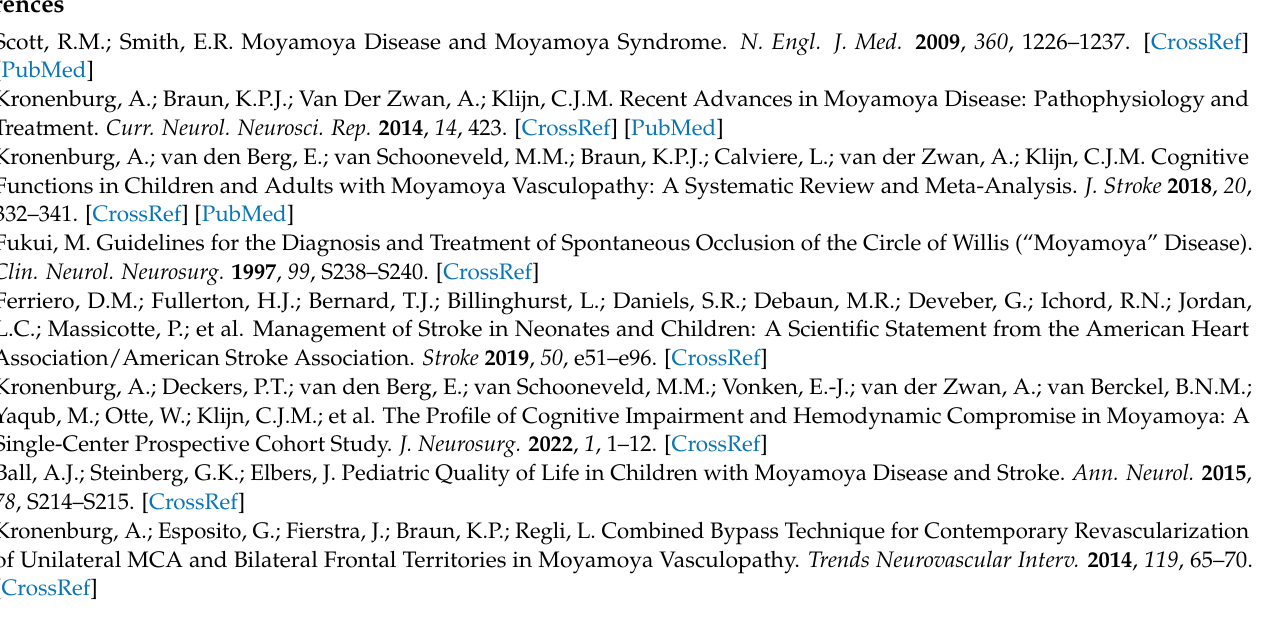
Figure A2. Z -scores at follow-up. ( A ) z -scores of neurocognitive tests on follow-up (conservative treatment) for the total group and for adults only for all seven cognitive domains. The numbers represent the amount of patients with a z -score below − 1.5 SD compared to the total number of patients with a valid domain score per group. Scores significantly different from the population mean (one sample t -test) are noted with * ( p < 0.05); ** ( p < 0.005). ( B ) change in z -score between baseline and follow-up. A higher score indicates an improvement. The numbers represent the amount of valid test scores per cognitive domain. There were no significant changes after follow-up.